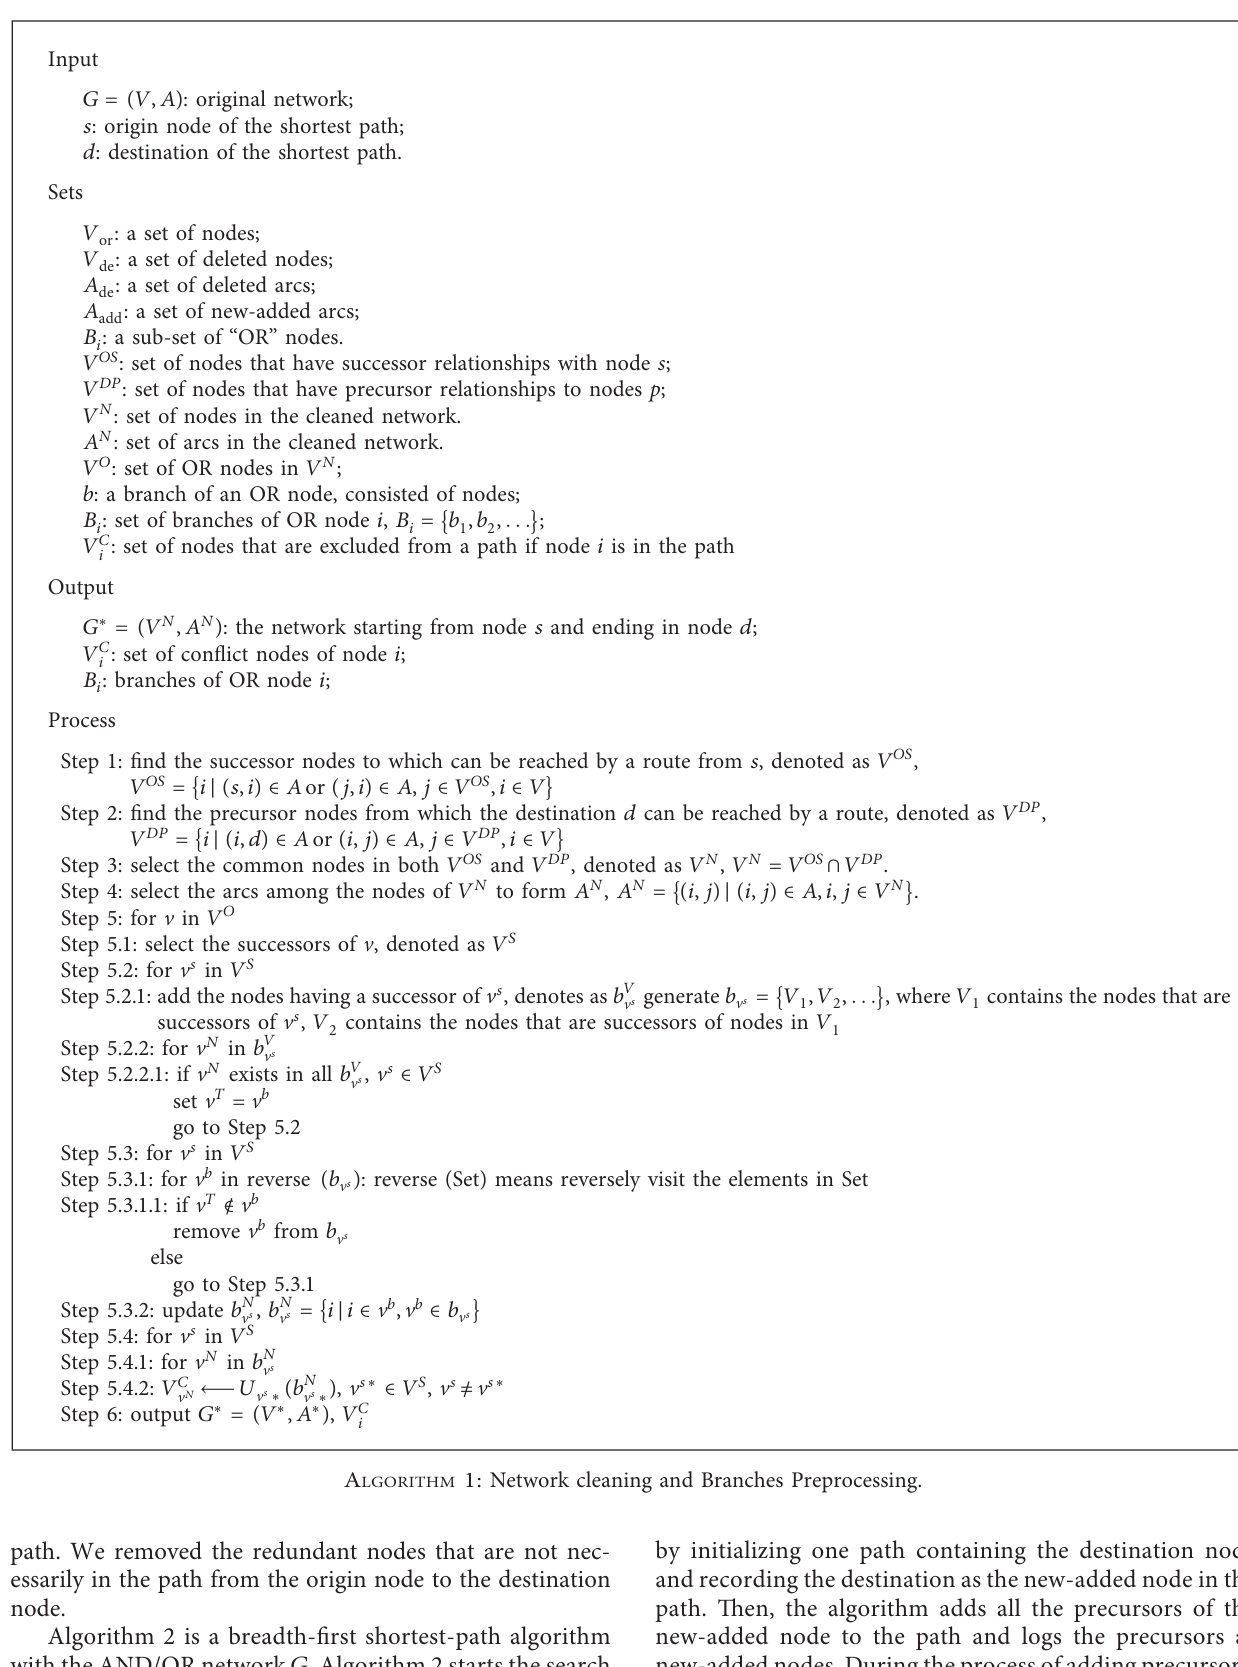
Algorithm 2 is a breadth-first shortest-path algorithm with the AND/OR network G . Algorithm 2 starts the